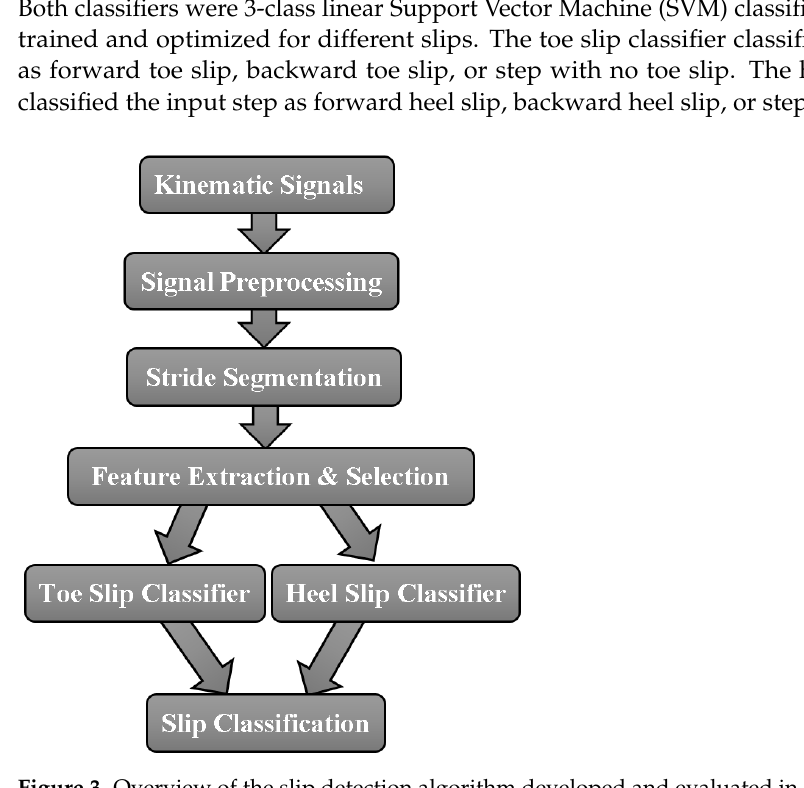
Figure 3. Overview of the slip detection algorithm developed and evaluated in this study.